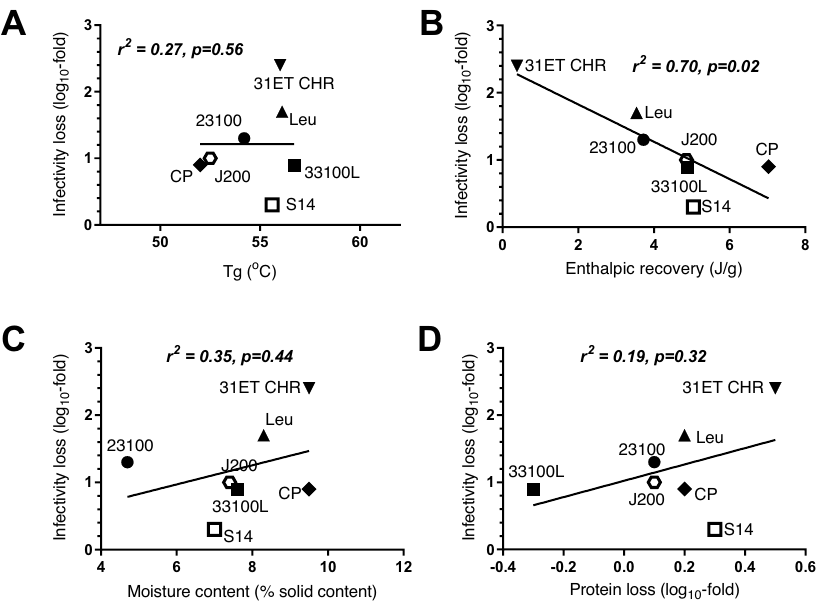
Figure 4. Relationships of sugar glass properties with vaccine thermostability on various matrices. Each panel relates the thermostabilisation performance of the various matrices (after 1-week thermochallenge at 45 °C, Y-axis, data shown in Table 1) to a potentially explanatory variable on the X-axis: glass transition temperature (panel A ); enthalpic recovery (panel B ); moisture content (panel C ); and protein recovery (panel D ). Results of Pearson correlation analysis are shown within each panel. DSC measurements (panels A and B ) were made in singlicate, Karl–Fischer measurements (panel C ) were made in duplicate, and protein loss measurements (panel D ) were made in triplicate. For panels ( C ) and ( D ), points represent the mean